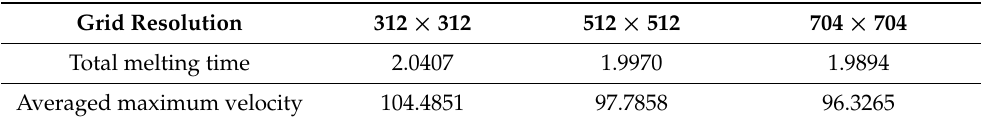
Figure 3. The comparisons of ( a ) charge density and ( b ) electric field strength at hydrostatic state between present numerical results and analytical solutions. Table 1. The total melting time and averaged maximum velocity at different grid resolutions. Parameters: Ra = 10,000, T = 1000, AR =